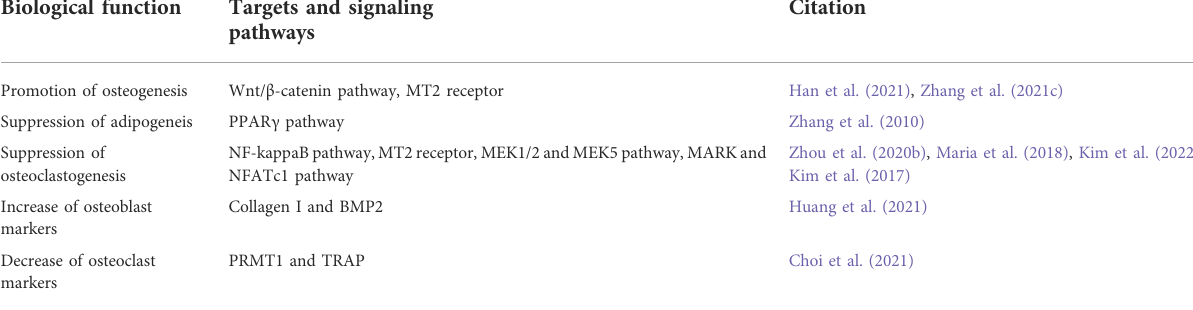
TABLE 1 The mechanism of melatonin regulating bone